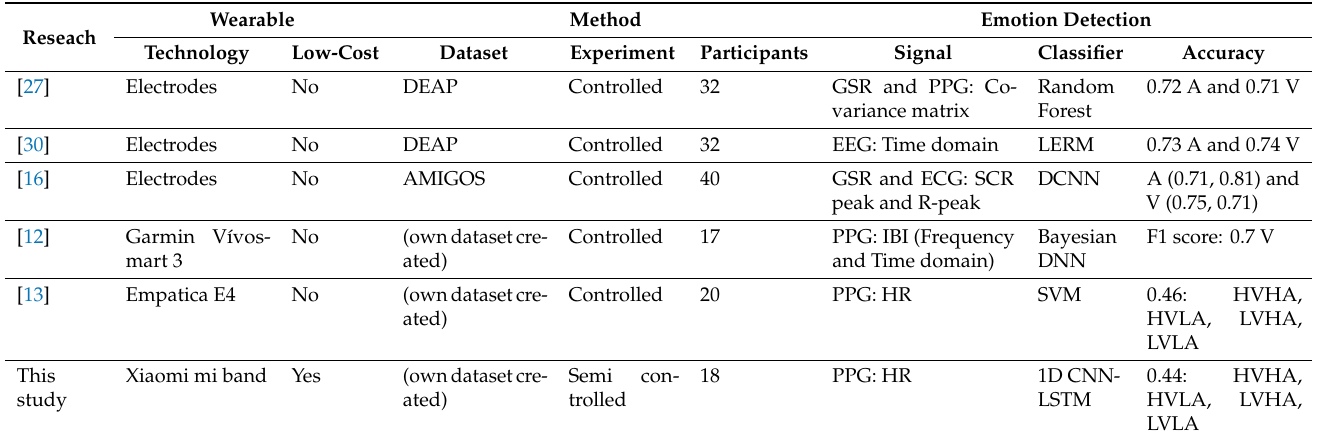
Table 2. Emotion detection studies based on physiological data from wearable